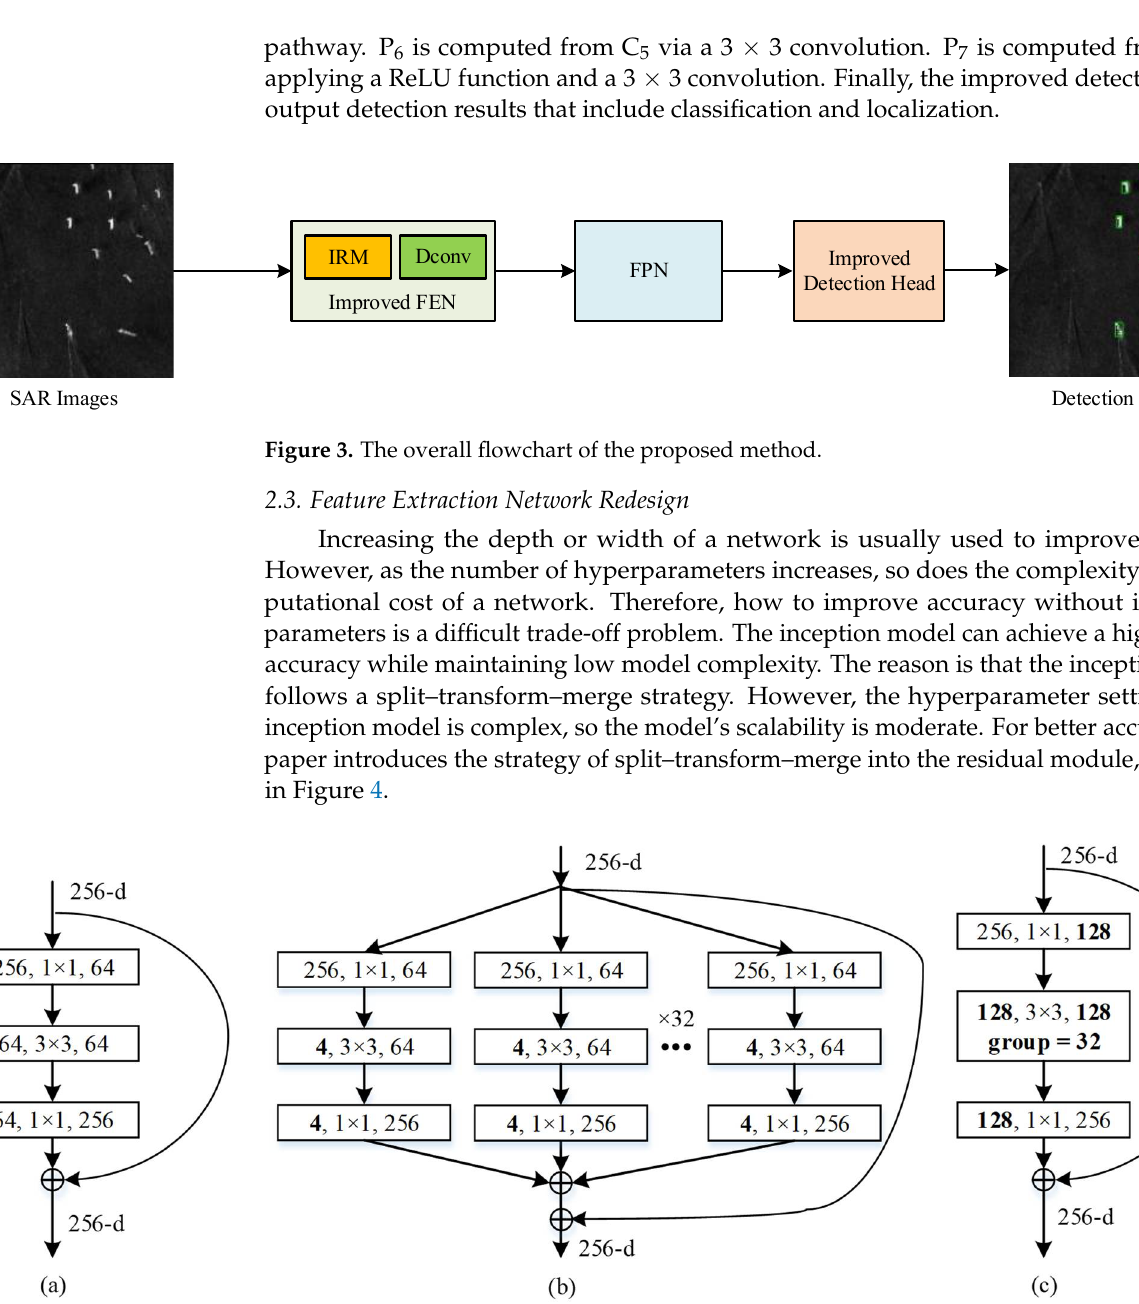
Figure 4. Schematic diagram of different modules. ( a ) The original residual module. ( b ) IRM. ( c ) IRM + Dconv. Notations in bold text highlight the reformulation changes. A layer is denoted as in channels, filter size, and out channels. ‘-d’ denotes the dimensionality of the feature map. 4a, the parameters of the original residual module are 256 × 64 + 3 × 3 × 64 × 64 + 64 × 256 = 69,632. In Figure 4b, the parameters of the IRM are 32 × (256 × 4 + 3 × 3 × 4 × 4 + 4 × 256) = 70,144. Therefore, the parameters